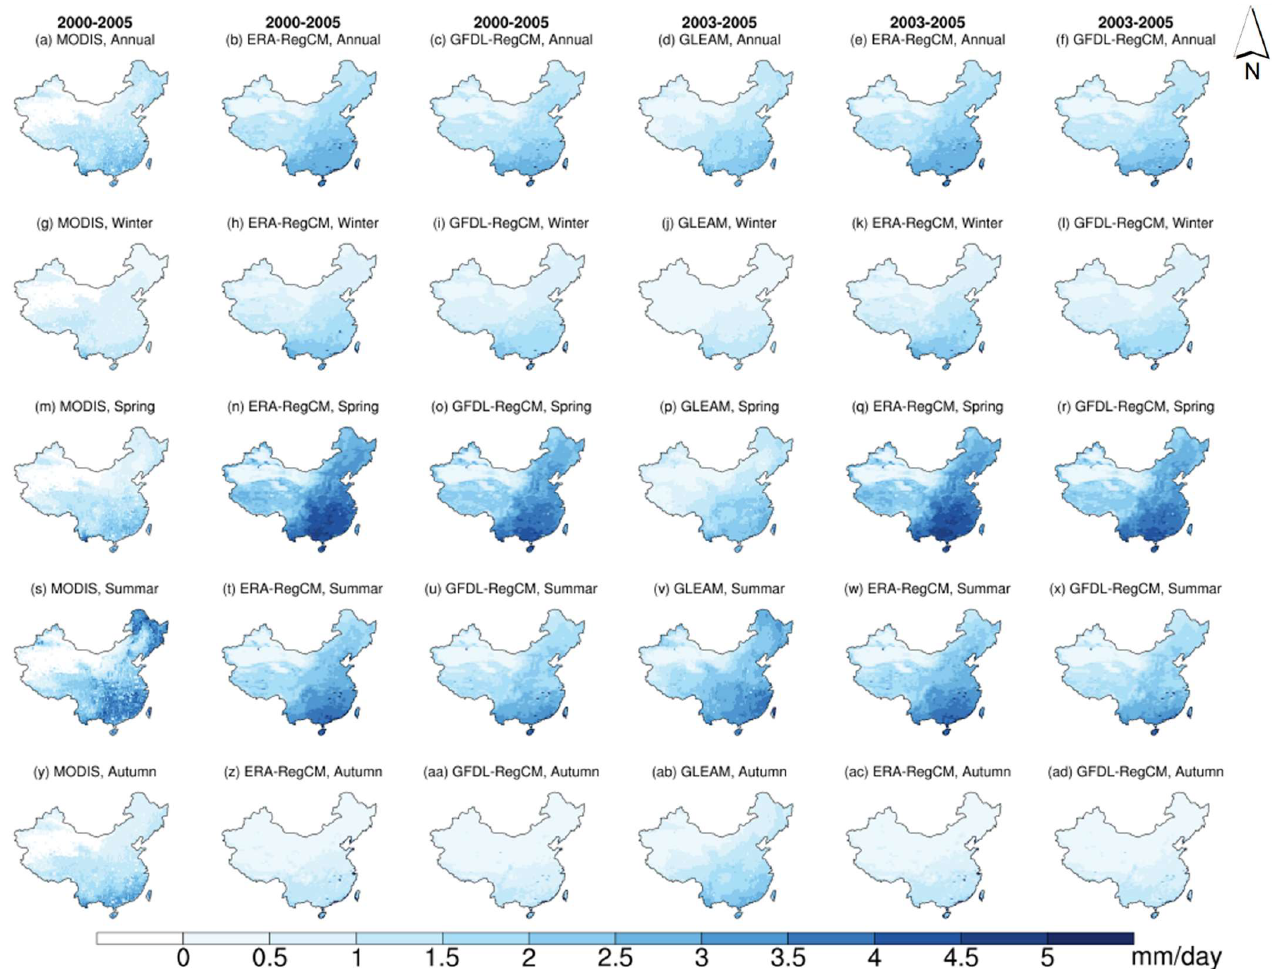
Figure 3. Remotely sensed and RegCM-simulated evapotranspiration over China. The annual and seasonal averages are calculated with respect to the period of 2000 to 2005 for MODIS and 2003 to 2005 for GLEAM.